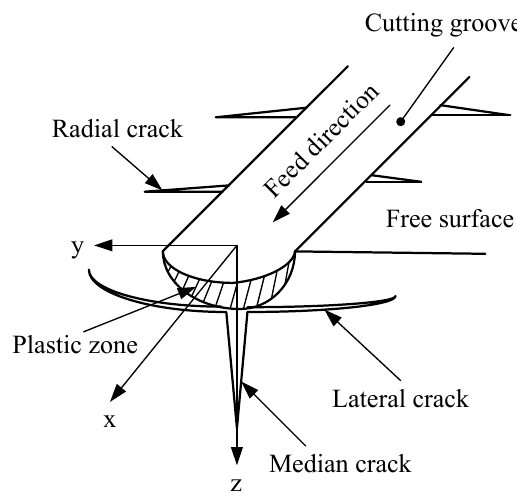
Figure 3. Ductile regime machining of brittle materials.